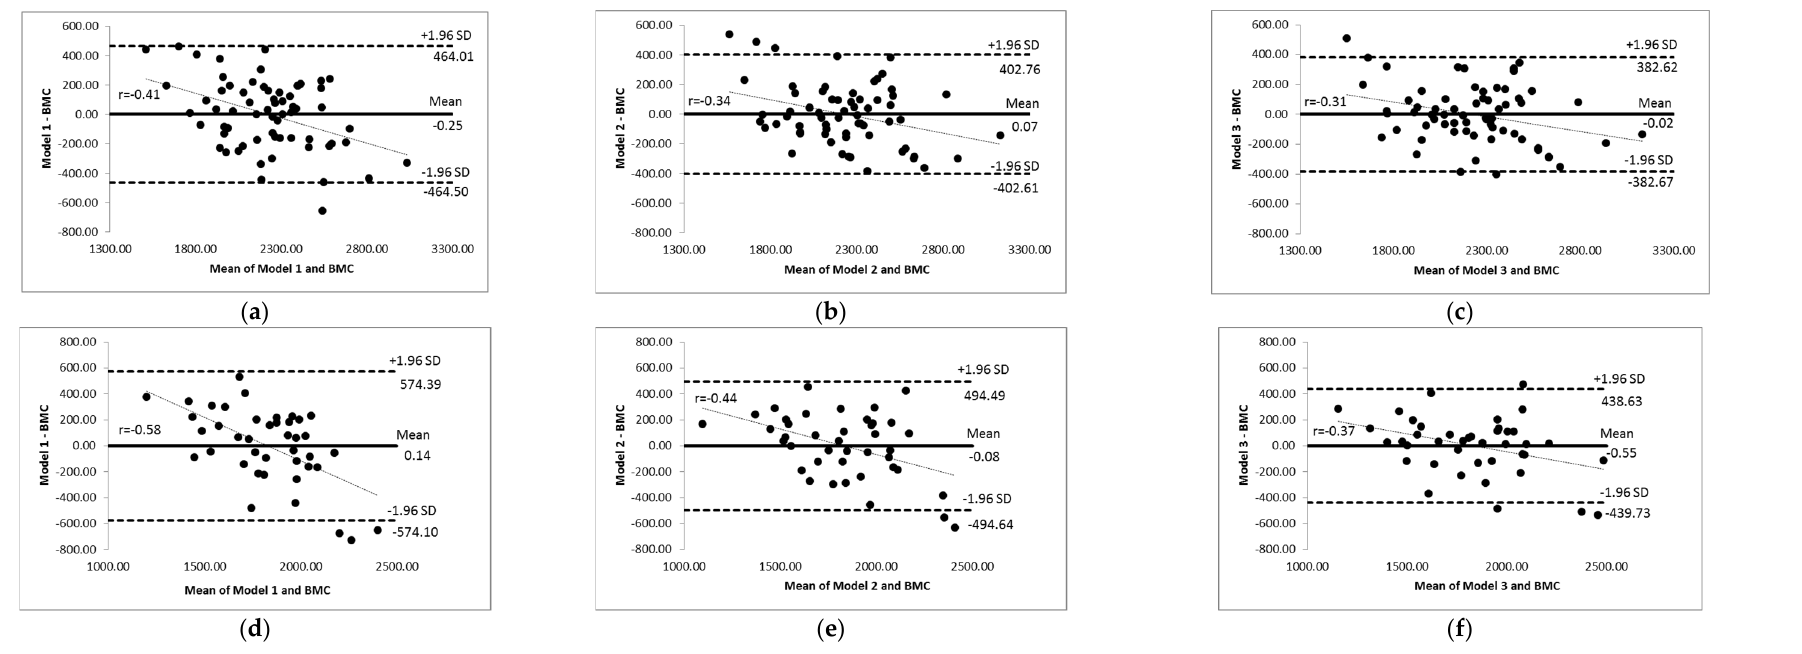
Figure 1. Bland–Altman plots for bone mineral content using DXA (BMC DXA ) and bone mineral content using anthropometric predictive models (BMC Mod_Anthr ) for males ( a – c ) and females ( d – f ) living with HI. ( a ) Bland–Altman plot (BMCMod_Anthr 1) for males. ( b ) Bland–Altman plot (BMCMod_Anthr 2) for males. ( c ) Bland–Altman plot (BMCMod_Anthr 3) for males. ( d ) Bland–Altman plot (BMCMod_Anthr 1) for females. ( e ) Bland–Altman plot (BMCMod_Anthr 2) for females. ( f ) Bland–Altman plot (BMCMod_Anthr 3) for females.